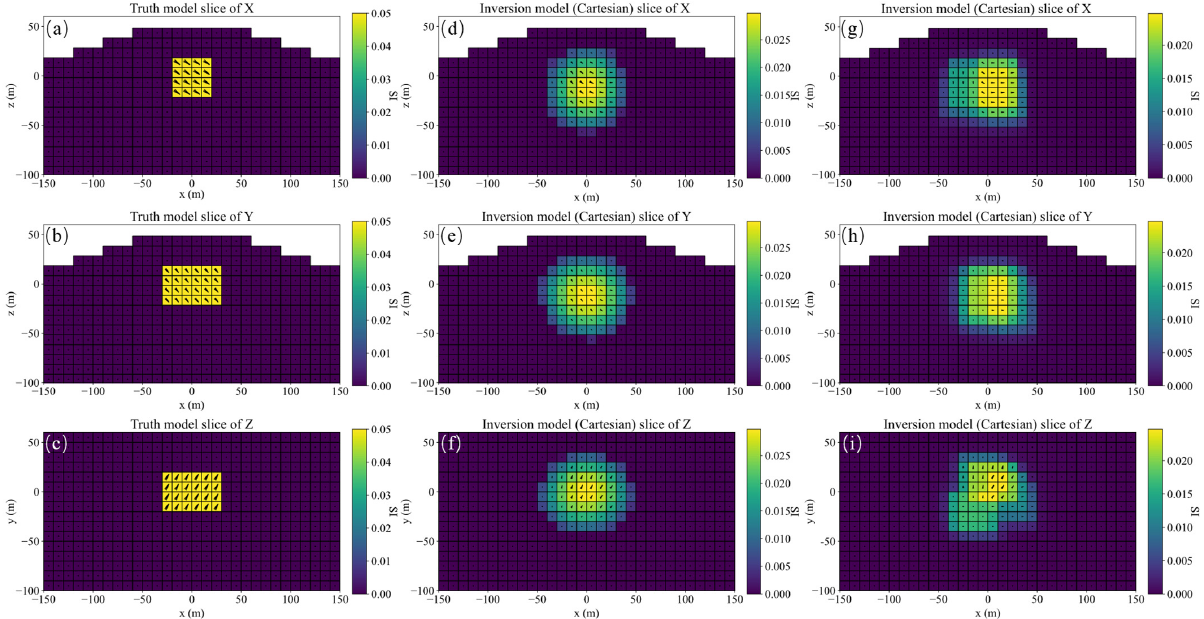
Figure 2. Slices in three Cartesian directions of the ground truth ( a – c ) and inverted model 1 ( d – f ) and model 2 ( g – i ) under different regularization and constraint parameters, respectively.